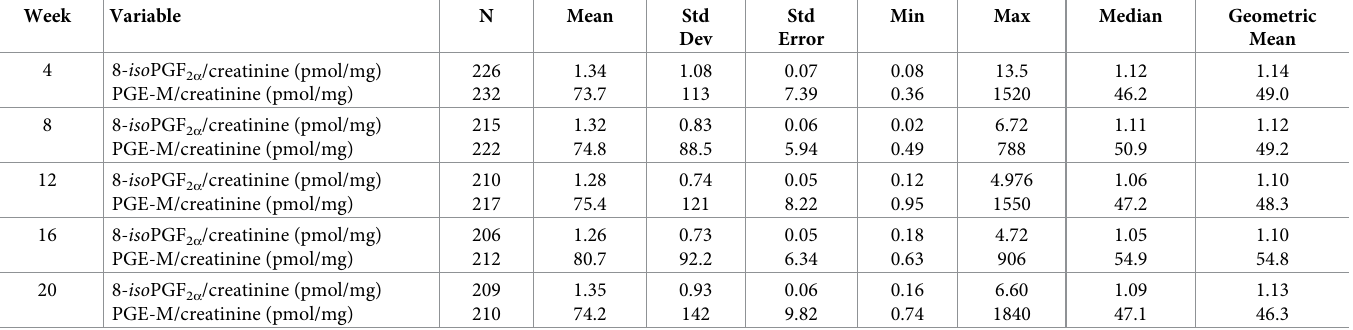
Table 1. Means and other summary statistics for 8- iso PGF 2 α and PGE-M per mg creatinine at each week of the study in the subjects who smoked the Spectrum